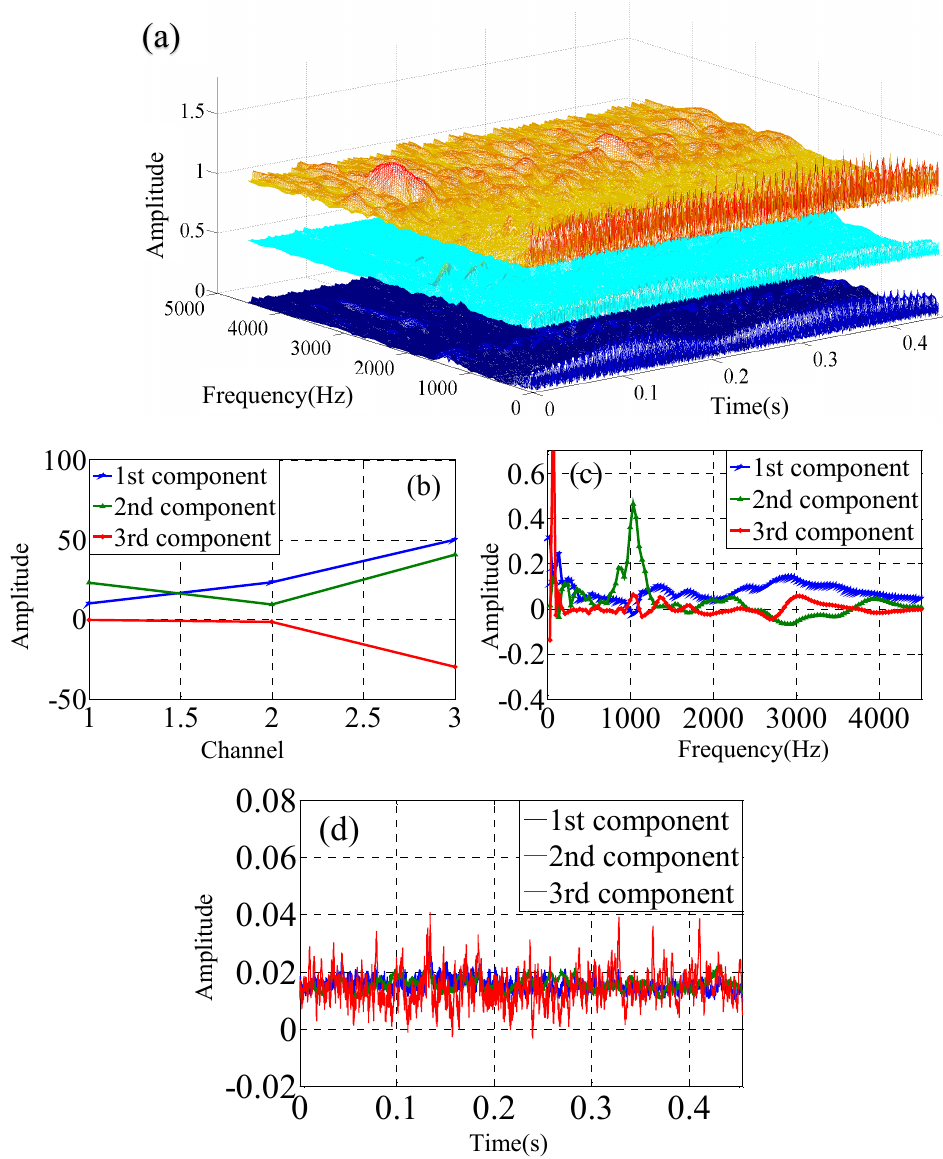
Figure 6. PARAFAC for time–frequency–space data matrix from three sensors under F1 condition. ( a ) Time–frequency–space with CWT of three-channel data, ( b ) mode 1, ( b , c ) mode 2, ( d ) mode 3.